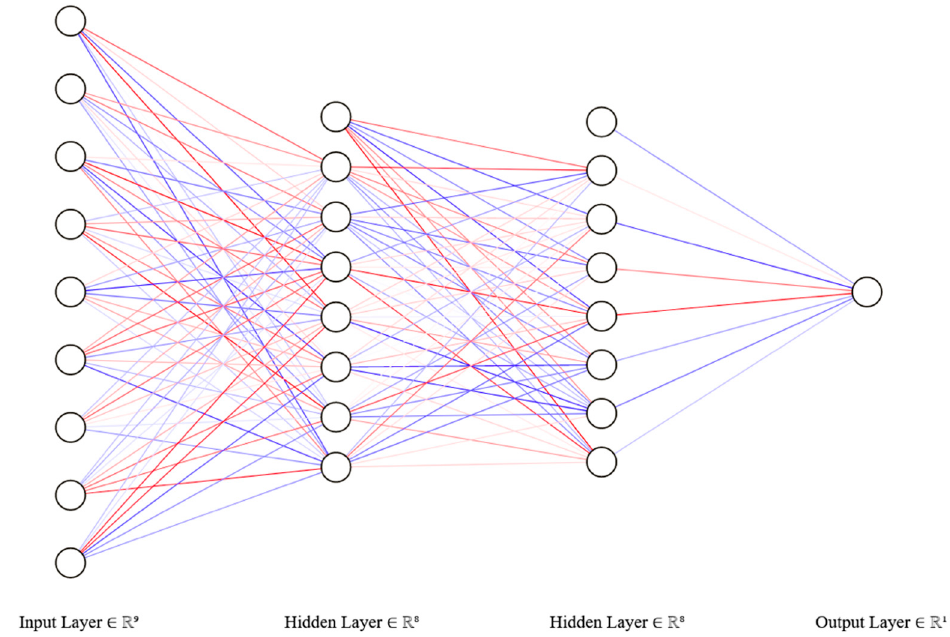
Figure 7. The ANN structure of our model.